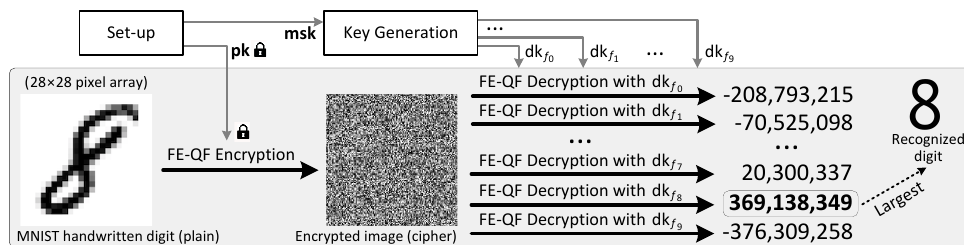
Figure 6: Visual representation of the MNIST use